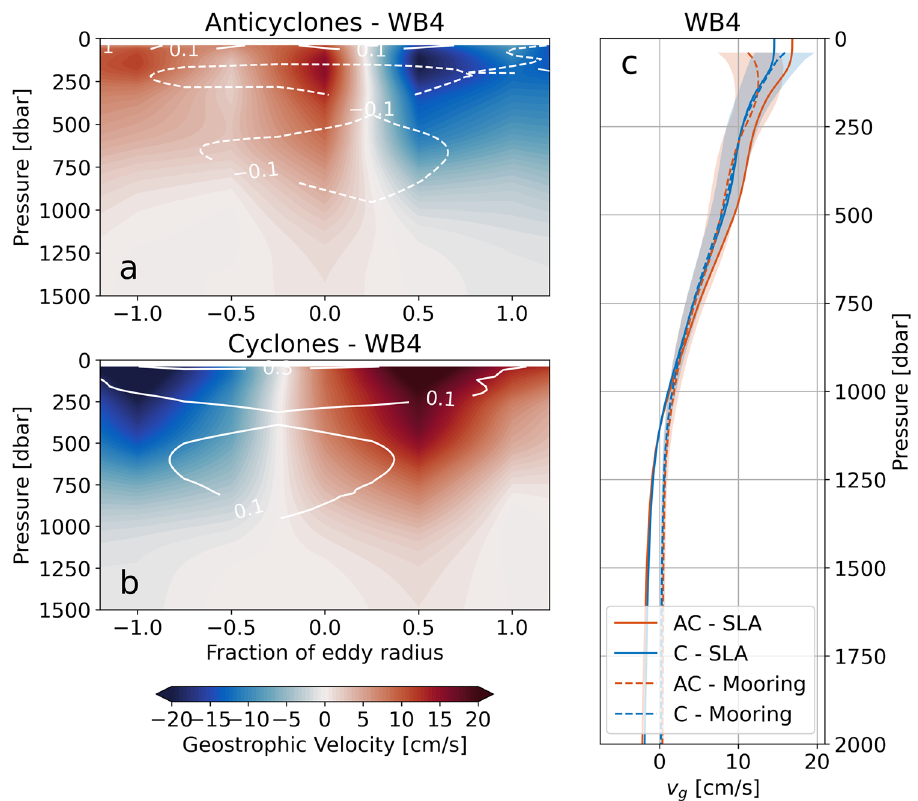
Figure 5. Mesoscale eddy geostrophic velocity at the RAPID/MOCHA mooring WB4. ( a ) Meridional geostrophic velocity calculated using the composite density ( ρ ) sections from the RAPID/MOCHA mooring WB4 for anticyclonic eddies. White contours show density anomaly (( ρ for cyclonic eddies. ( c ) A comparison between geostrophic velocity at the RAPID/MOCHA mooring WB4 (dashed lines) and the velocity profiles estimated from surface geostrophic velocity derived from altimetry data, assuming sub-surface first mode baroclinic structure (solid lines) for anticyclonic (orange) and cyclonic (blue) eddies. The shading indicates an uncertainty range for the mooring-based estimate using Monte-Carlo based bootstrapping to calculate upper and lower bounds for